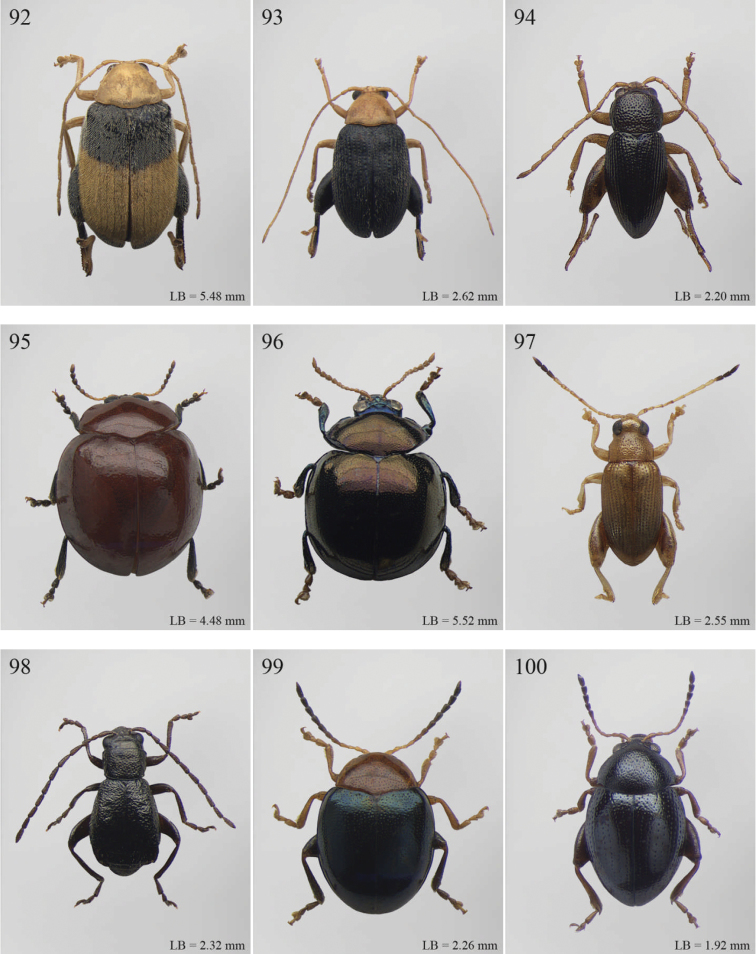
Habitus. 92
Sanckia lebisi Bechyné 93
Sanckia (ex Eugonotes Jacoby) longicornis (Jacoby) 94
Serraphula elongata Jacoby 95
Sesquiphaera mashonana (Jacoby) 96
Sesquiphaera (ex Paropsiderma Bechyné) near vadoni (Bechyné) 97
Seychellaltica mahensis (Maulik) 98
Sjostedtinia montivaga Weise 99 Sphaeroderma femoratum Jacoby 100
Stegnaspea trimeni Baly.